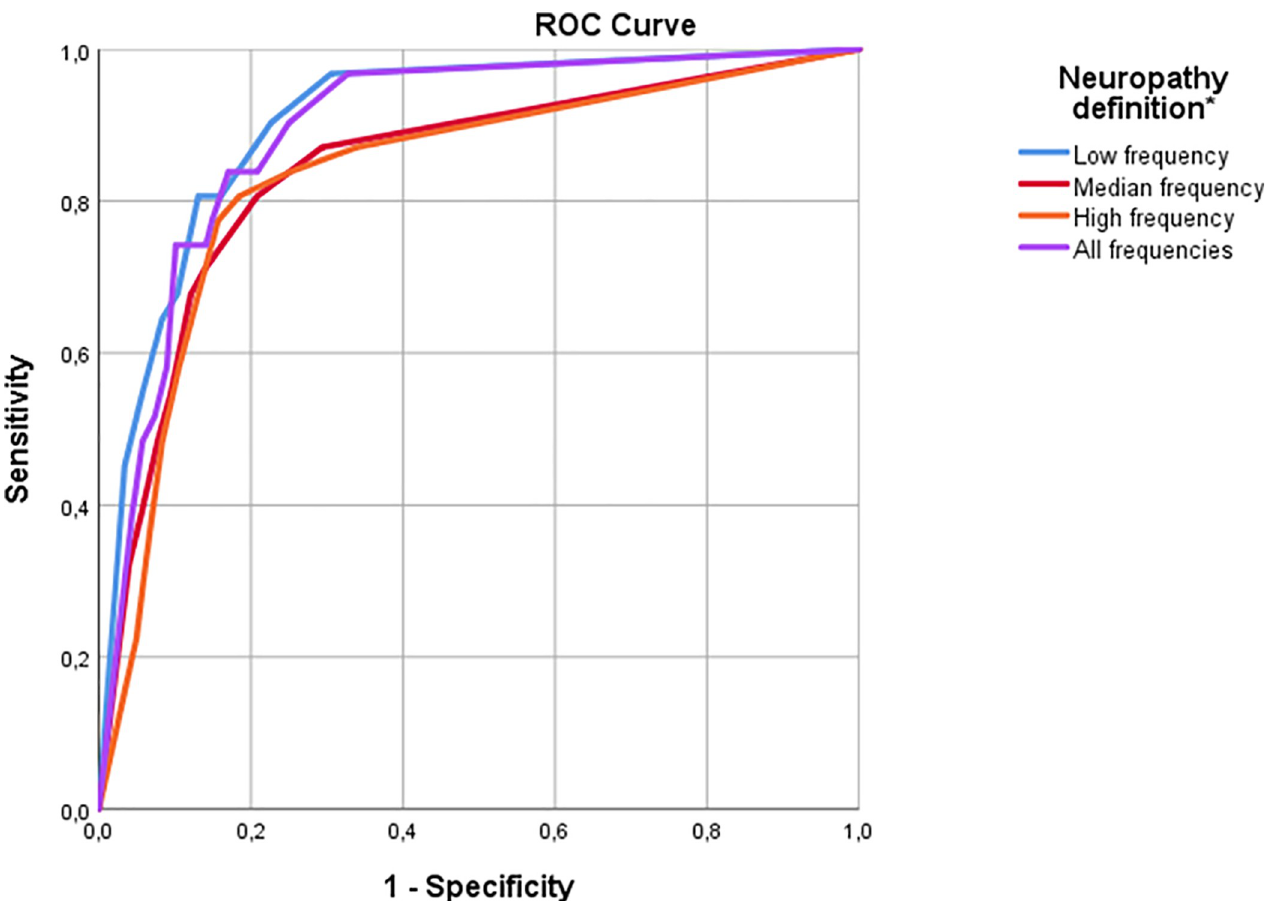
Fig 3. Receiver operating characteristic (ROC) curve of number of VPT frequencies over normal predicting diabetic foot ulcers. Number of low frequencies (4 or 8 Hz) over normal range: AUC = 0.91[0.84-.096], p = 3.1x10-14. Number of median frequencies (16 or 32 Hz) over normal range: AUC = 0.84 [0.77–0.92],p = 1.3x10-10. Number of high frequencies (64 or 125 Hz) over normal range: AUC = 0.83[0.76–0.91], p = 4.0x10-10. Number of all frequencies over normal range: AUC = 0.89[0.83–0.94], p = p = 5.3x10-13.